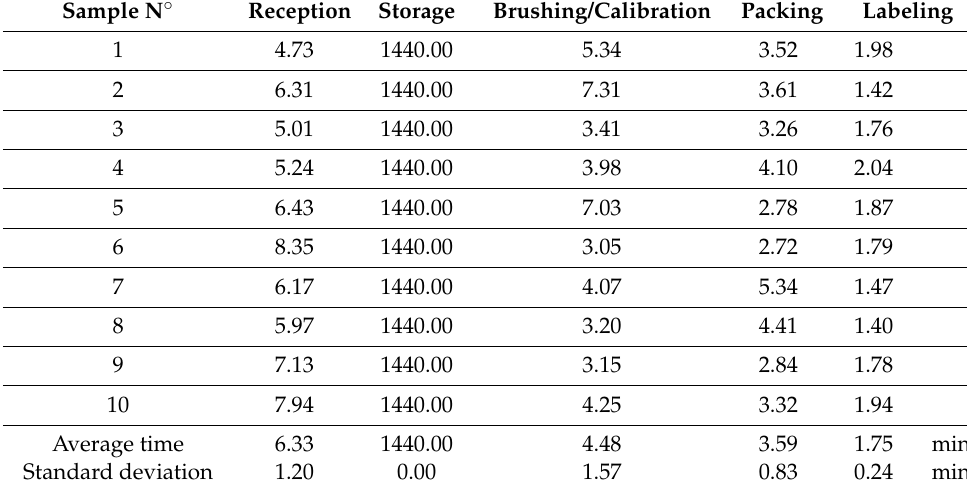
Table 1. Timing of sample